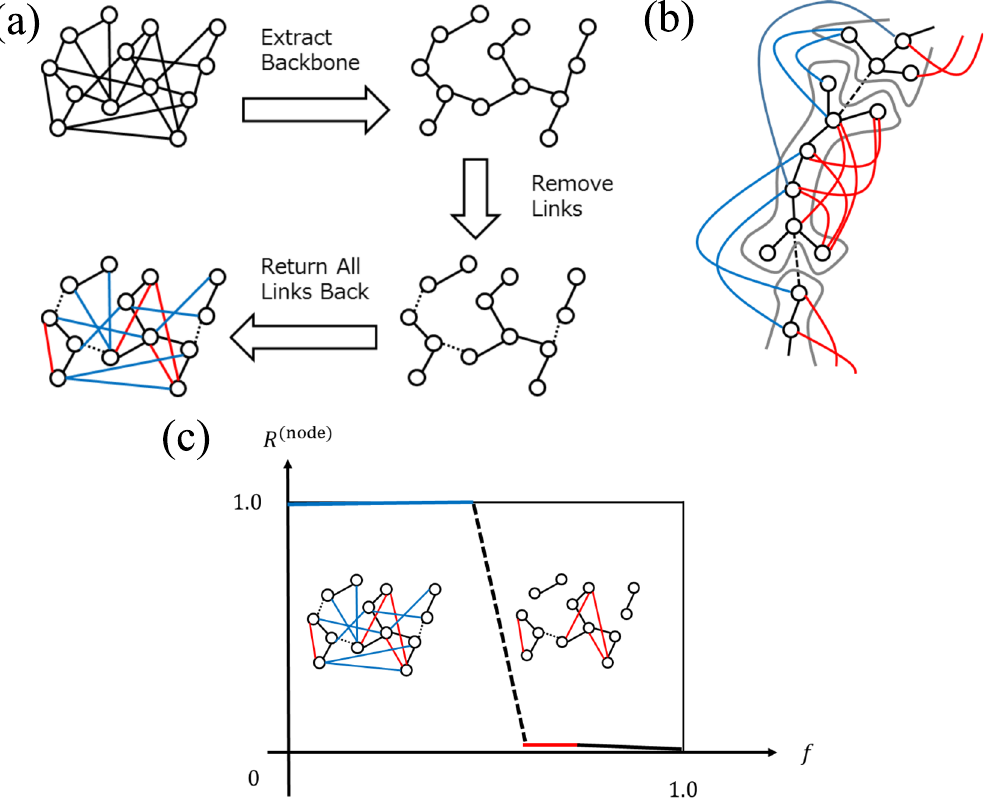
Figure 1. ( a ) Schematic figure of link classification process. For a given network, a spanning tree is computed; then the network is decomposed into many clusters by removing links. Finally, all links are returned to their original location. ( b ) Schematic figure of clusters. The bone links (black lines) form the skeleton of each cluster. The fat links (red lines) connect two nodes within a cluster. The cartilage links (black dotted lines) connect clusters to an element of a backbone. The muscle links (blue lines) are links that connect two different bone clusters after the final procedure of returning links to their original positions. ( c ) Schematic figure showing the relationship between the order parameter R (node) , and the control parameter for the anatomical percolation. Firstly, muscle links are removed randomly (blue line). Secondly, cartilage links are removed randomly (black dotted line). Thirdly, fat links are removed randomly (red line). Finally bone links are removed randomly (black line). The order parameter mainly changes during the second process of removing cartilage